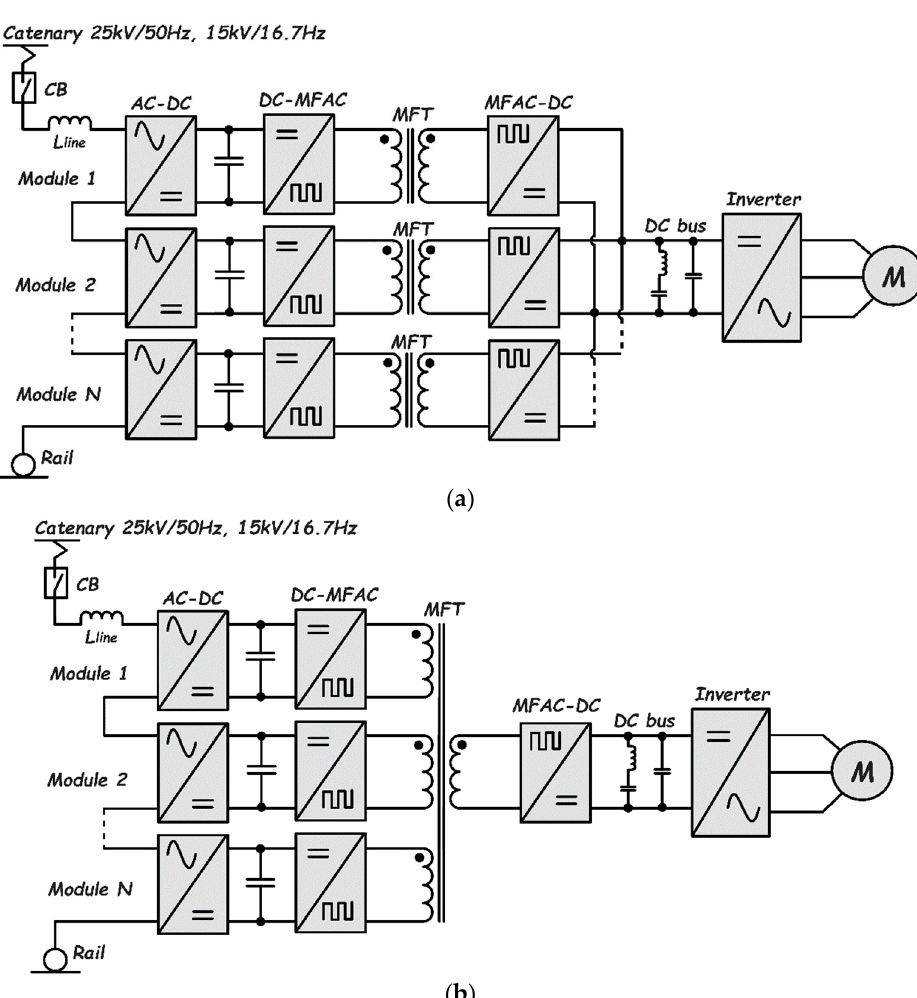
Figure 17. Different configurations of three-stage cascaded PET: ( a ) parallelized at the inverter input; ( b ) with superposition at the transformer.